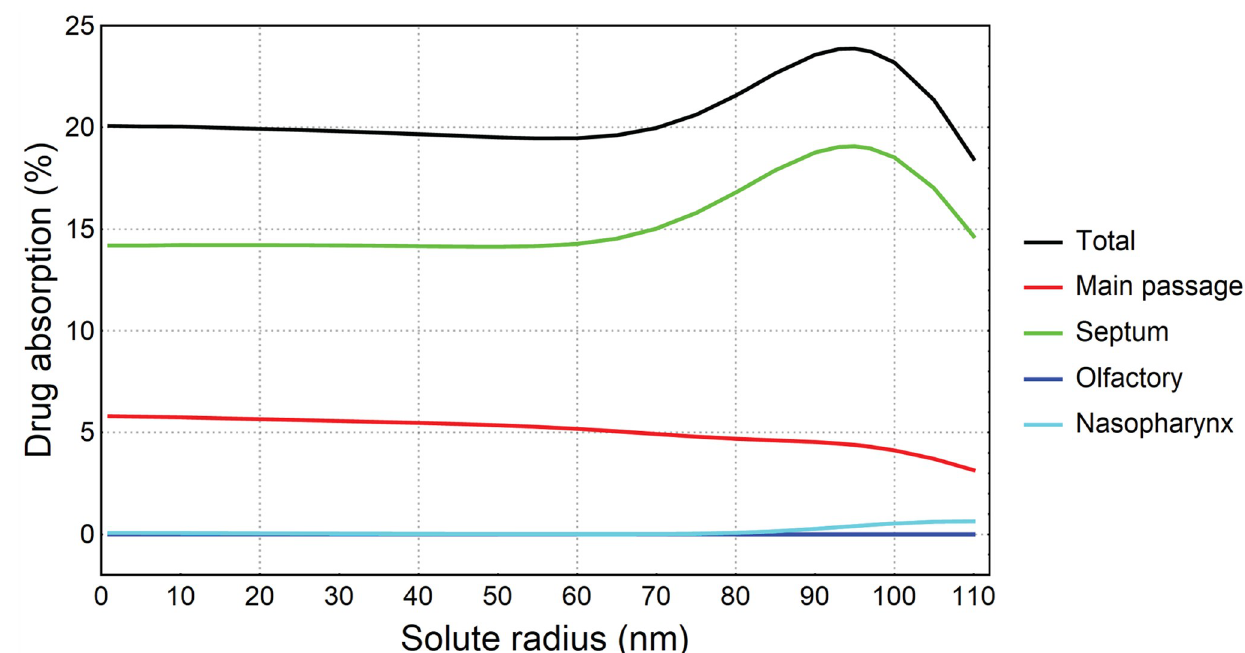
Fig 9. Total and regional drug absorption over drug solute